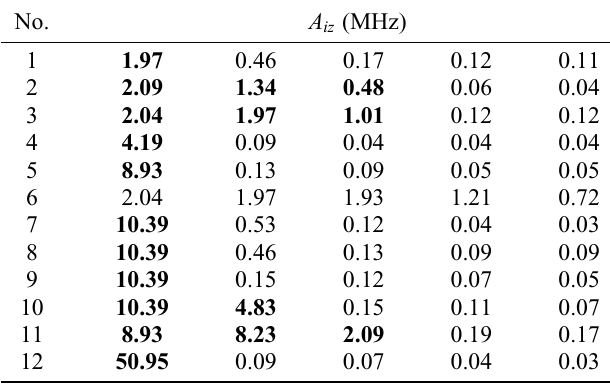
TABLE I. Highest five hyperfine couplings A iz of the config- urations, shown in Fig. 16. The nuclear couplings giving rise to the peak splitting are highlighted in bold.